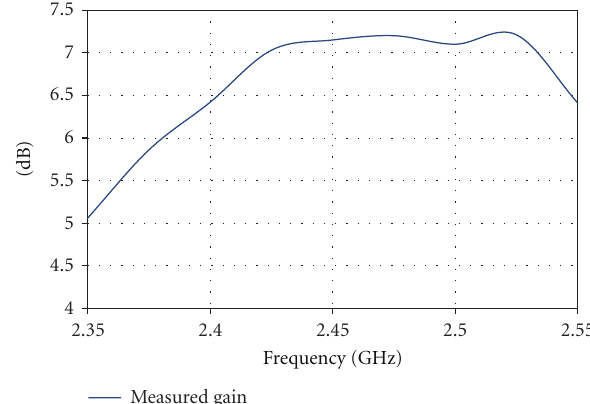
Figure 17: Simulated return loss of the dual-beam printed dipole antenna.